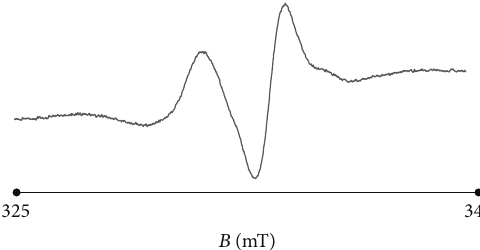
Figure 4: EPR spectra of bismuth subgallate thermally sterilized at 160 ∘ C (120 minutes). 𝐵 —magnetic induction. The spectra were measured with attenuation of 15dB at liquid nitrogen